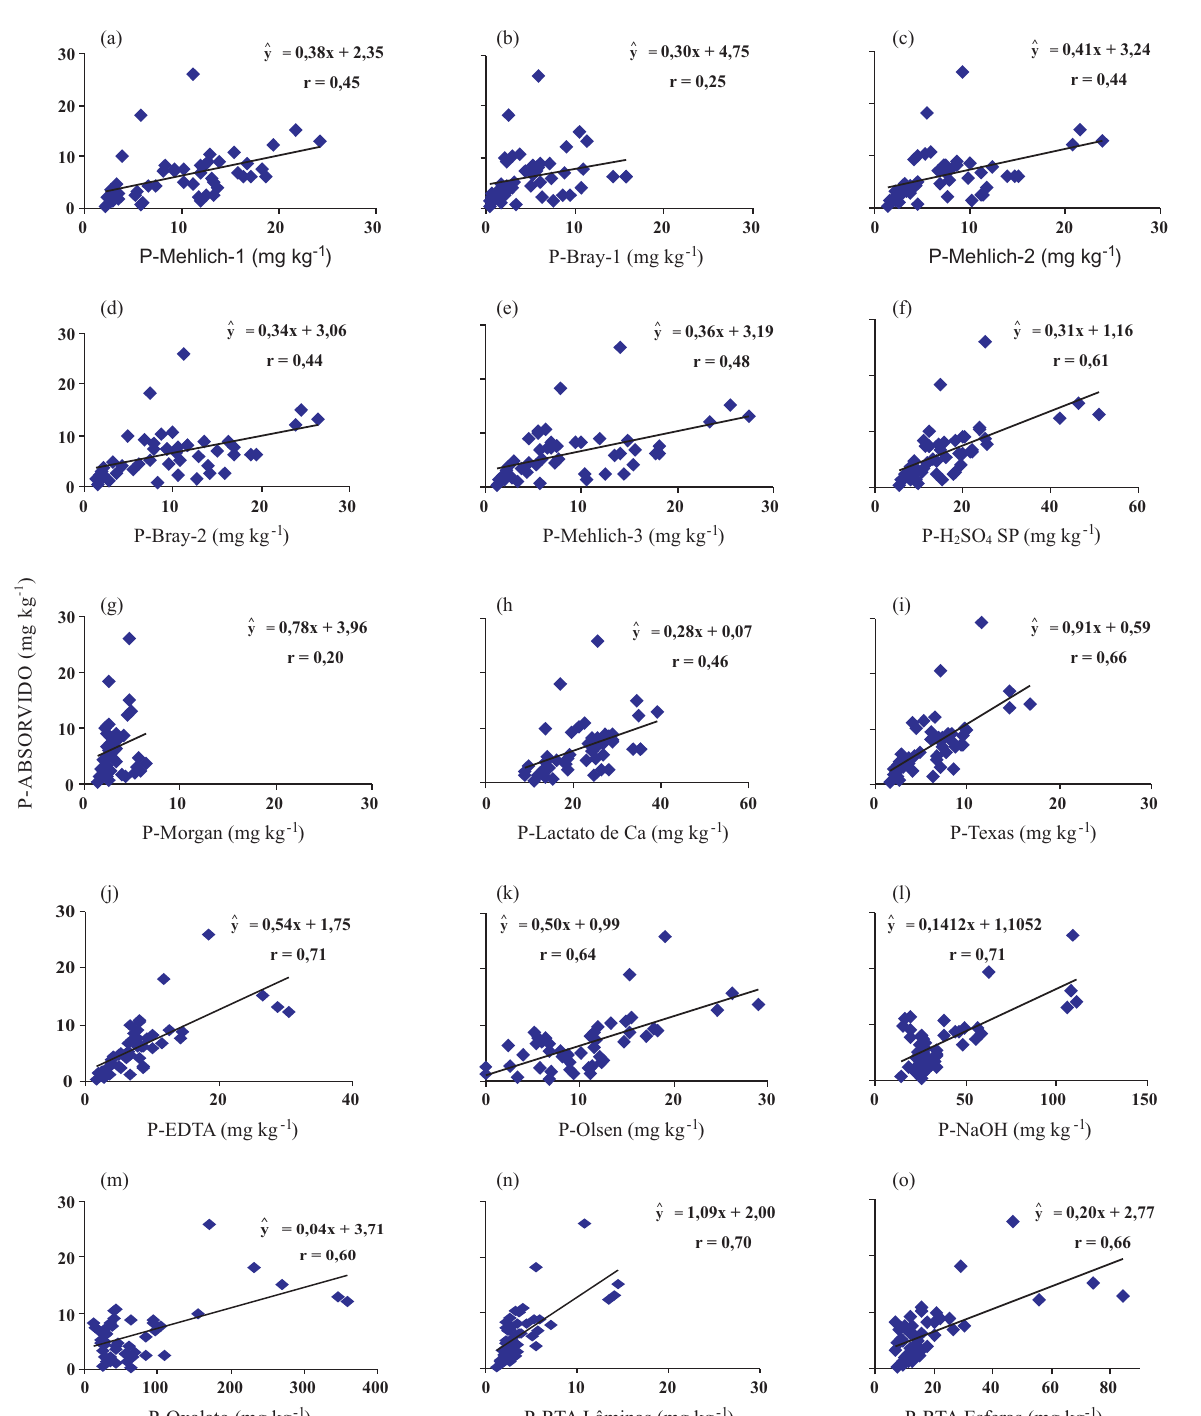
Figura 1. Correlações entre as quantidades de fósforo absorvidas pelo arroz e os teores de fósforo avaliados pelos extratores (a) Mehlich-1, (b) Bray-1, (c) Mehlich-2, (d) Bray-2, (e) Mehlich-3, (f) H (h) Lactato de Ca, (i) Texas, (j) EDTA, (k) Olsen, (l) NaOH, (m) Oxalato, resina trocadora de ânions (RTA) em (n) lâminas e (o) RTA em esferas. (n =